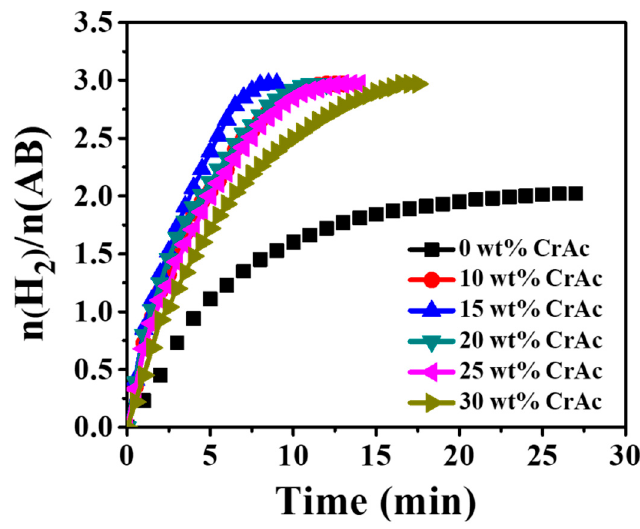
Figure 5. Evolution of H 2 gas by the hydrolytic dehydrogenation of AB in the presence of Cr 2 Ni 3 NPs@CNFs with different CrAc compositions.